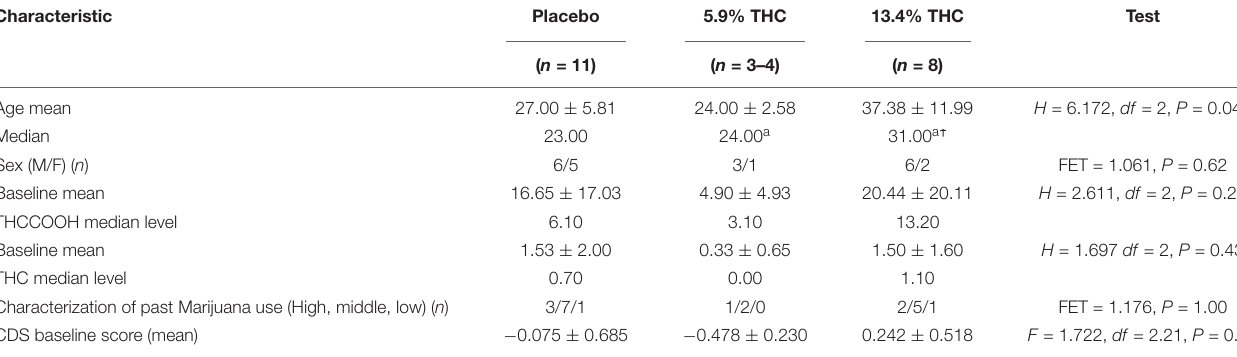
TABLE 2 | Characteristics of subjects in the three THC concentration